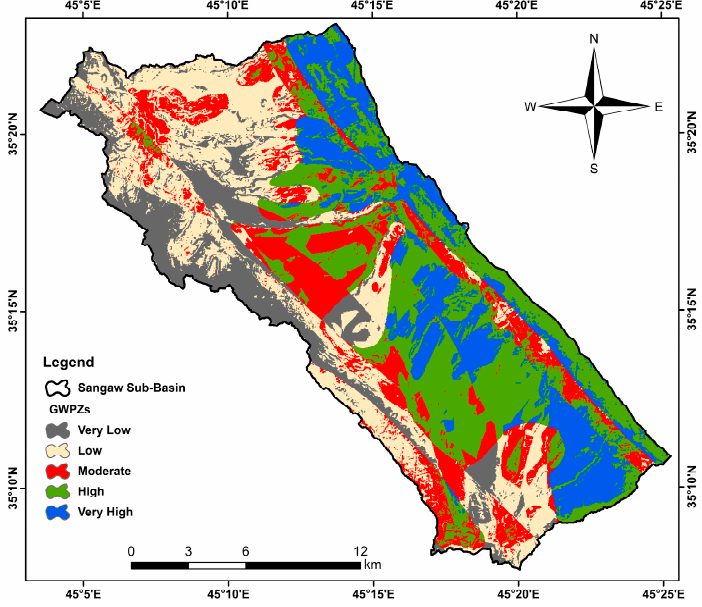
Figure 6. Groundwater potential zones map of Sangaw sub-basin.